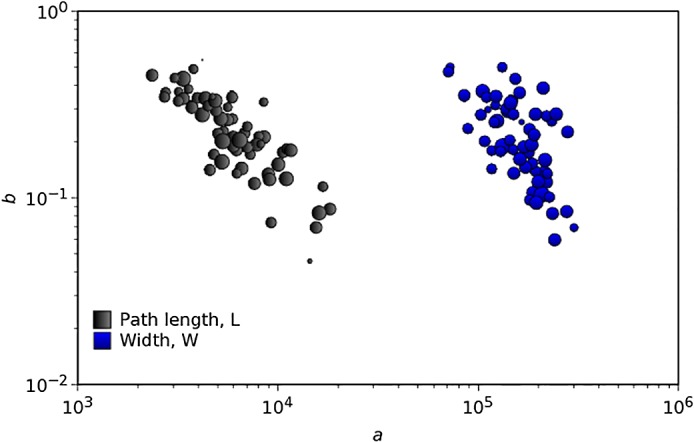
Loci of the PL parameters (a
i, b
i) for all years, i = 0, …, 63, considering the tornadoes path length, L, and width, W, to quantify intensity.A larger (smaller) diameter of the bubbles means a larger (smaller) value of the fitness function of the PL fit.